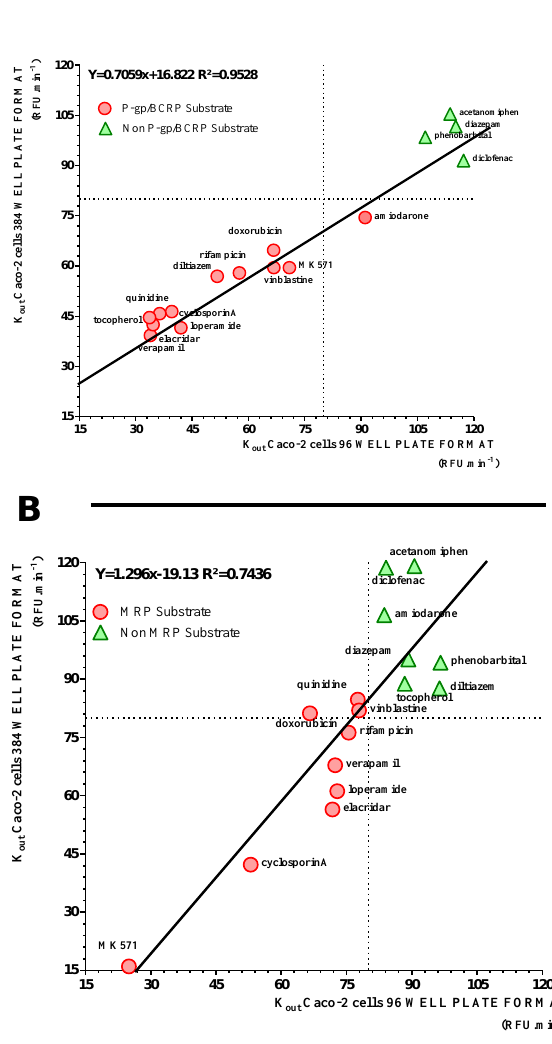
Figure 6. ( a ) Correlation between K out of R123 obtained using the 96- and 384-well plate formats. ( b ) Correlation between K out of CMFDA obtained using the 96- and 384-well plate formats. Classification: Interaction with efflux pumps when K out ≤ 80% of control.